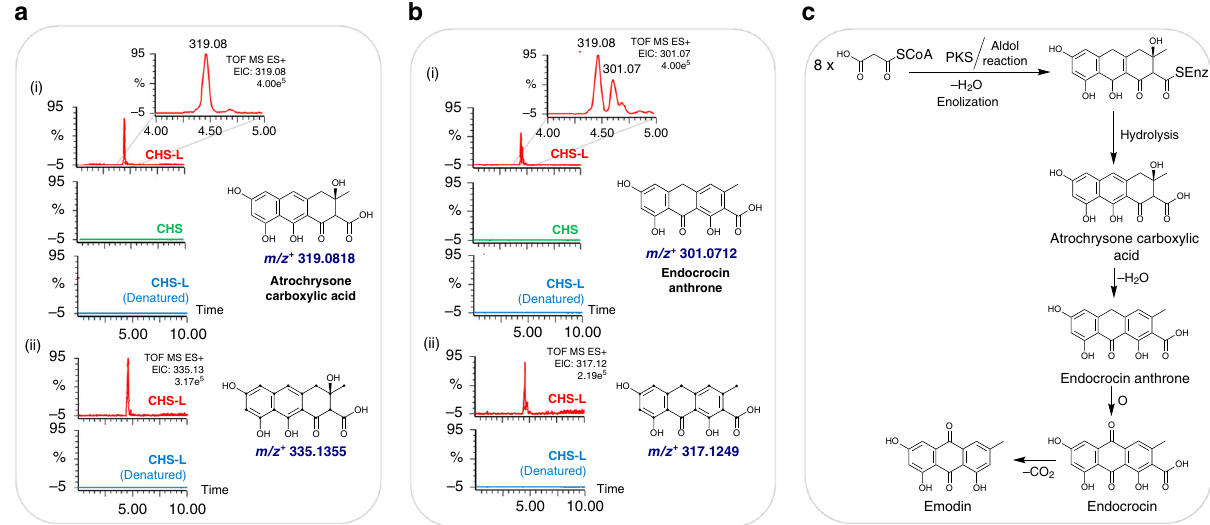
Fig. 3 Enzyme assays and MS analysis of anthraquinones. a (i) Extracted ion chromatograms (EIC) for the compound with the mass 319.08 Da in reaction mixtures containing malonyl-CoA as substrate and chalcone synthase-like (CHS-L9) (STO07G228250), chalcone synthase (CHS) (STO03G058250), or heat-denatured CHS-L9. (ii) EIC for the mass 335.13 Da in reaction mixtures containing 13 C 3 -malonyl-CoA containing CHS-L9 or heat-denatured CHS-L9 enzyme. Dots in the structure represent 13 C-labeled carbons. b (i) EIC for the mass 301.07 Da in reaction mixtures containing malonyl-CoA as substrate containing CHS-L9, CHS, or heat-denatured CHS-L9. The inset shows a zoomed region of the EIC chromatogram. (ii) EIC for the mass 317.12 Da in reaction mixtures containing 13 C 3 -malonyl-CoA containing CHS-L9 or heat-denatured CHS-L9 enzyme. c PKS-mediated biosynthetic pathway of anthraquinones. Two pathway intermediates, atrochrysone carboxylic acid and endocrocin anthrone, were produced in the CHS-L9-catalyzed reaction (Supplementary Figs. 16, 17, and Supplementary Data 5, 6).